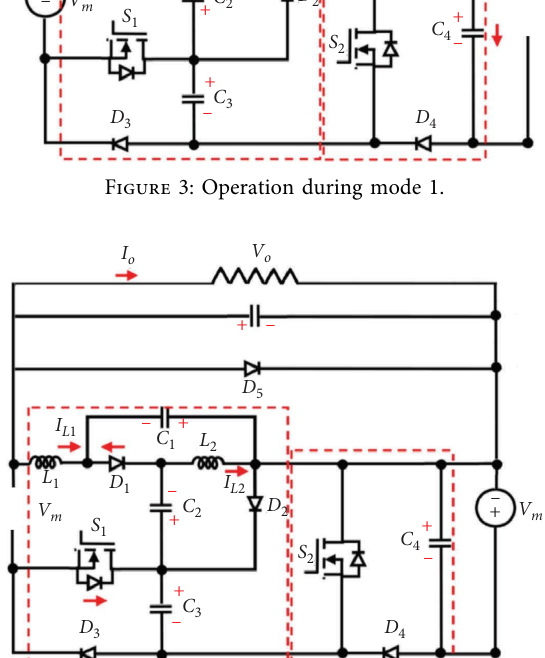
Figure 4: Operation during mode